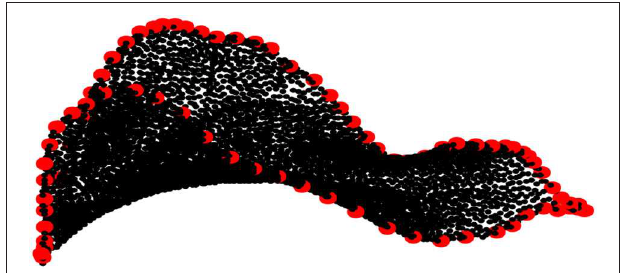
FIGURE 1 | The 4,688 Anthurium leaf data points (black dots) and the 79 boundary points (red